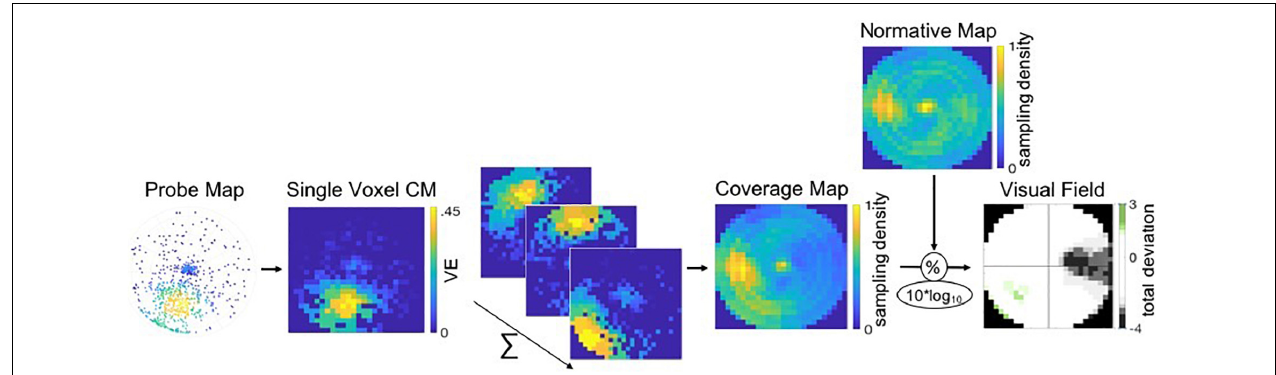
FIGURE 3 | Pipeline of the VF, or coverage map, reconstruction of a patient using MP. Probe-maps are converted to single CMs per voxel. CM of voxels within a ROI are summed and CM across ROIs are averaged. Individual full-field CMs are normalized to a 0–1 scale and divided by a normative VF map. The resulting total deviation plot indicates whether the deviation is within normal limits (i.e., the 90% CI depicted in white) or below and above normal limits, as depicted by the gray and green tones, respectively.